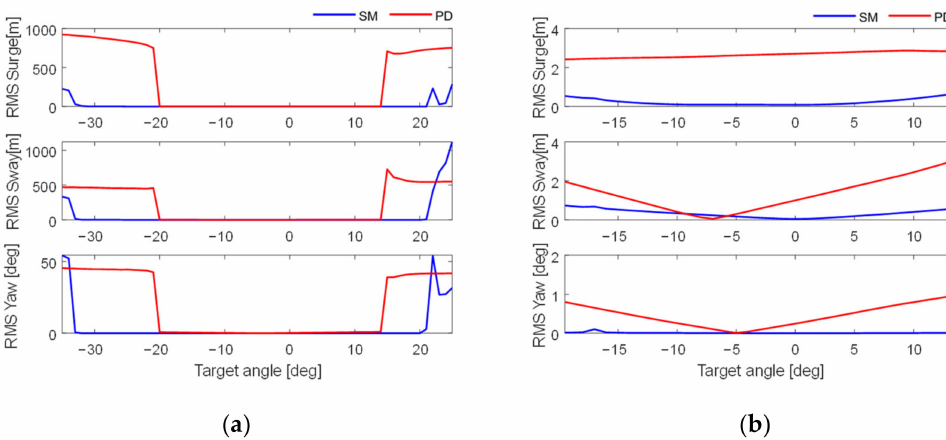
Figure 17. RMS values of errors of the motions of the FPSO vessel in steady state condition: ( a ) Target angle between − 35 to 25 ◦ and ( b ) Target angle between − 20 to 14 ◦